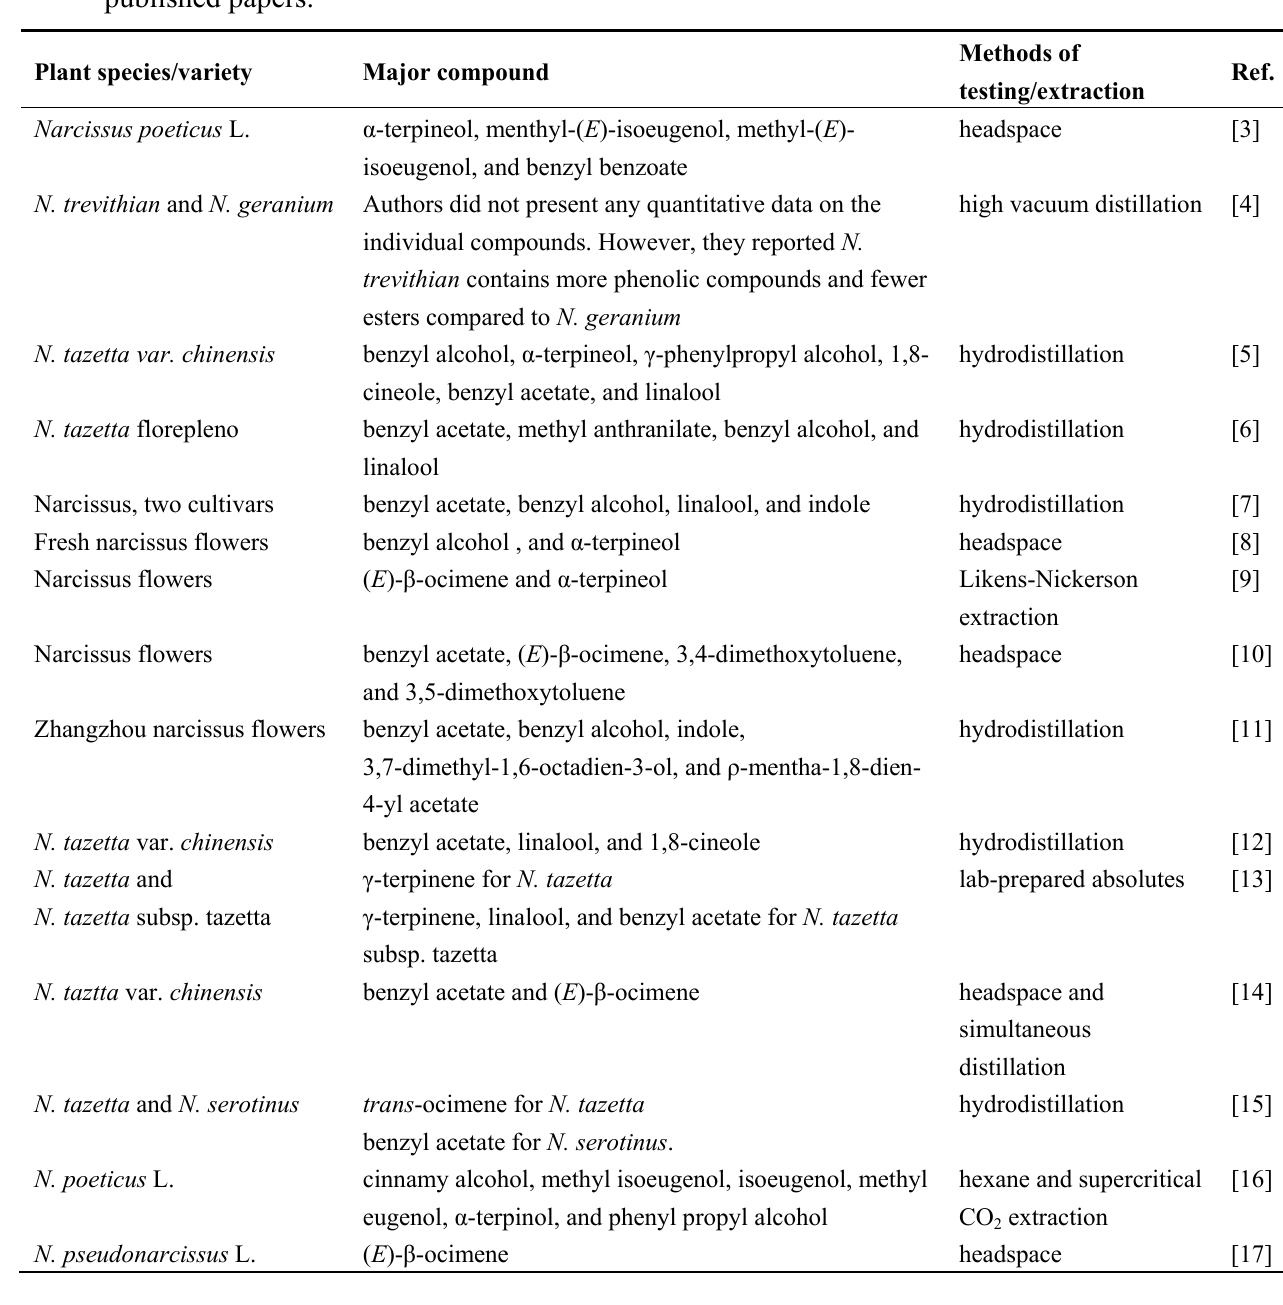
Table 1. Comparisons of major volatile compounds reported in Narcissus flowers in published